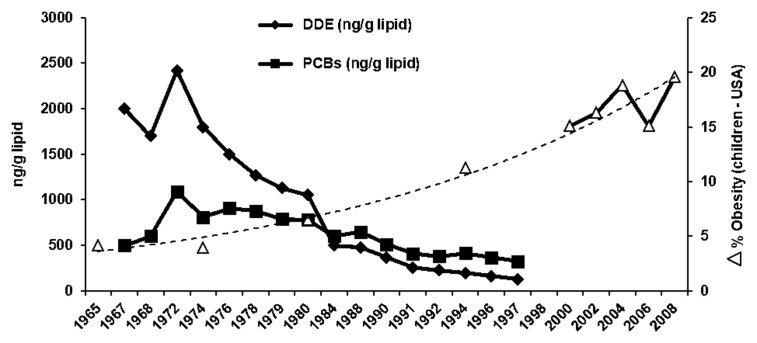
Time-dependent changes in dichlorodiphenyl dichloroethene (DDE) (♦) and total polychlorinated biphenyl (PCB) (■) levels in human milk21 and time-dependent increases in percentage of obesity (Δ) of 6- to 11-year-olds in the US21.